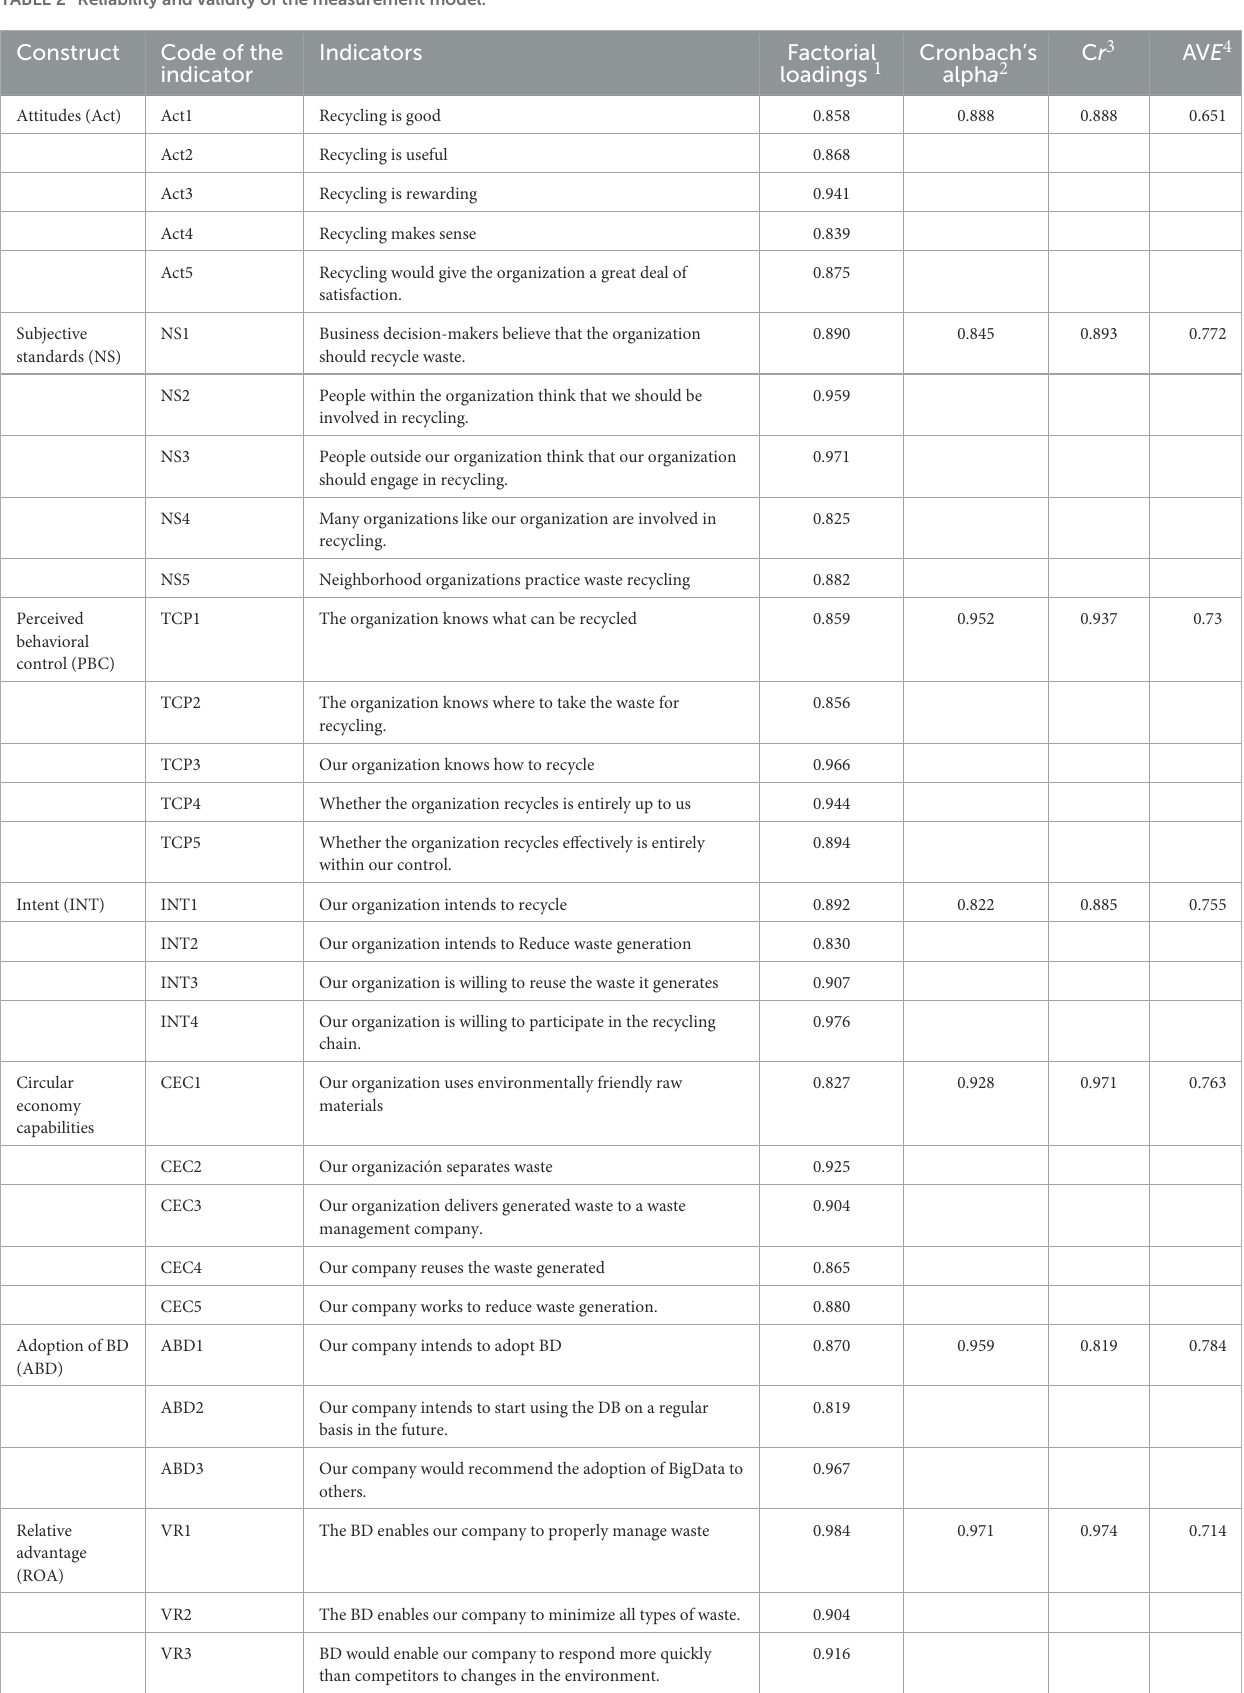
TABLE 2 Reliability and validity of the measurement